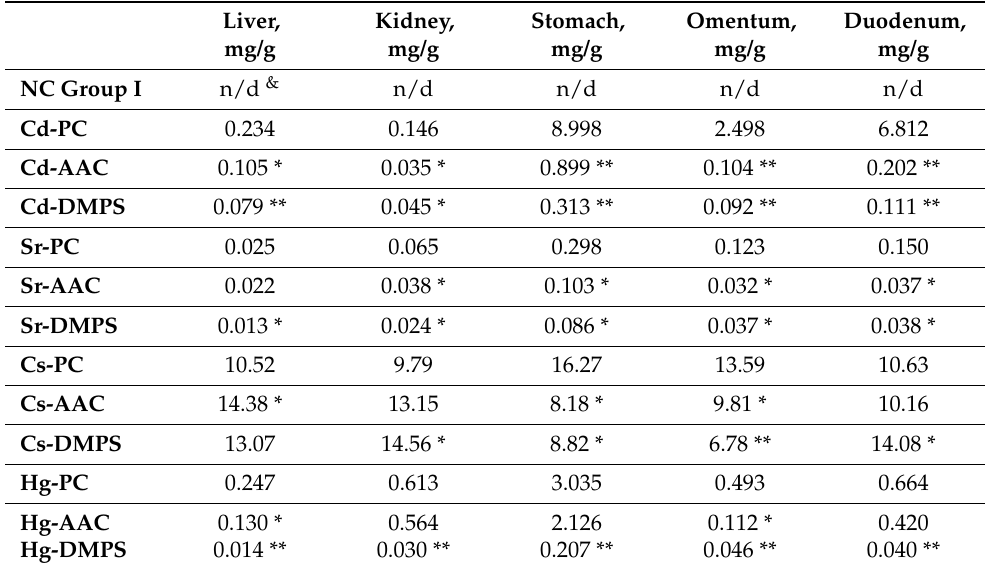
Table 3. Concentration of metal ions in the various tissues of experimental